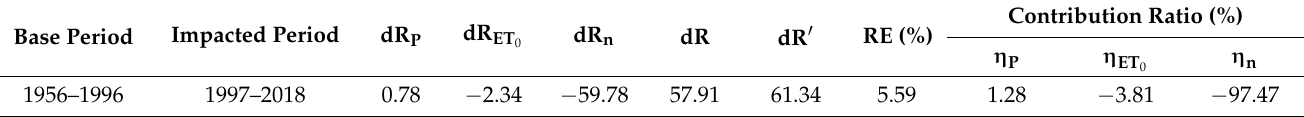
Table 6. Contributions of P, E0 and n to runoff depth change by Choudhury and Yang equation. Base Period Impacted